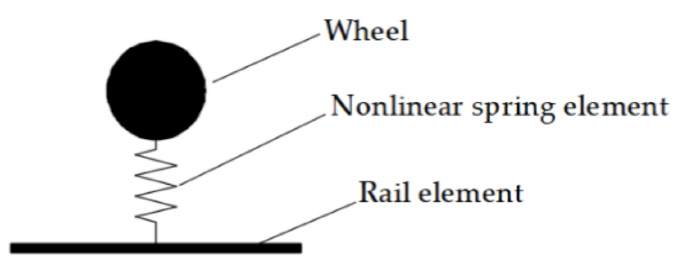
Figure 4. Wheel-rail interaction